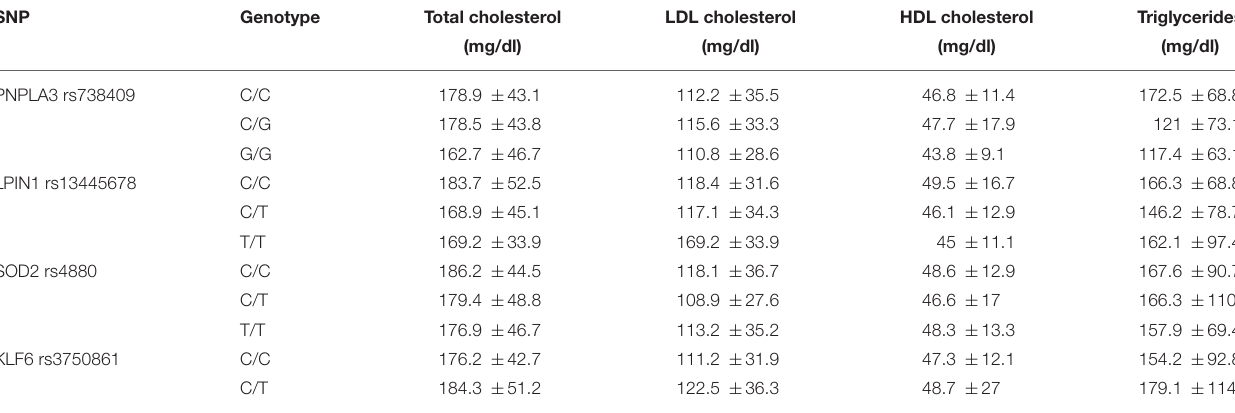
TABLE 3 | Lipid profile in the diabetic patients according to the SNPs and genotypes.